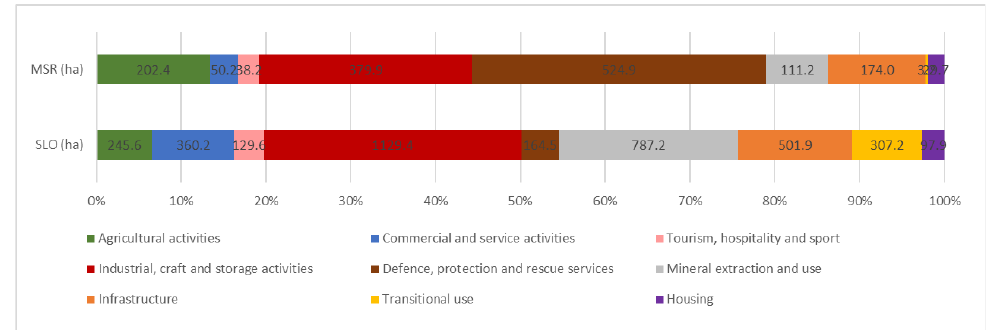
Figure 4. Comparison of brownfields in Slovenia (SLO) and the Moravian-Silesian region (MRS) by Figure 4. Regenerated brownfields by the type (2017–2022). Based on [24–27]. Prepared by the total area (ha) and by brownfield type. Based on [25,27]. Prepared by the authors.